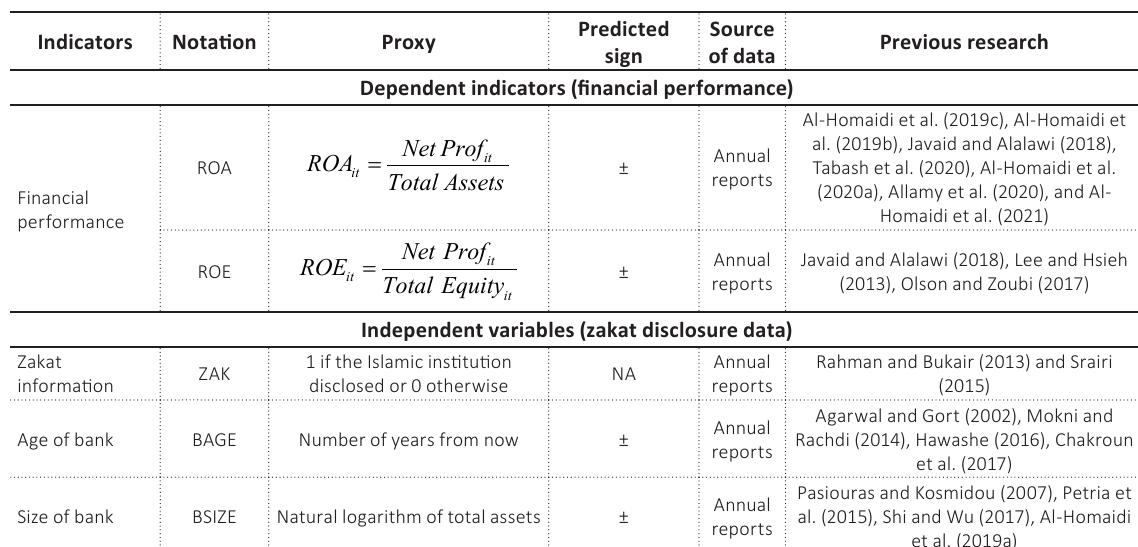
Table 1. Definition of research